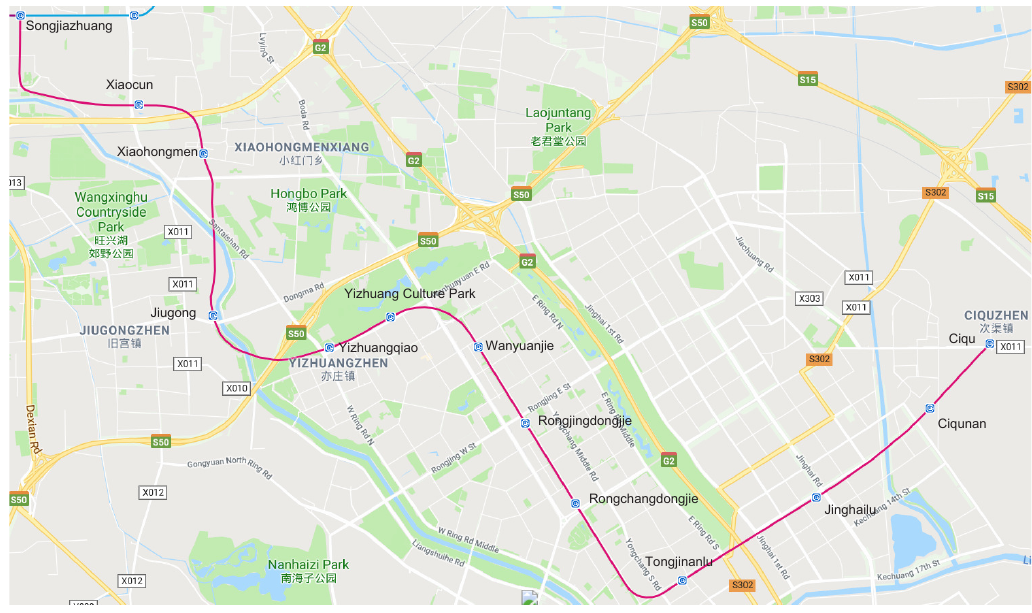
Figure 3. Beijing Yizhuang subway